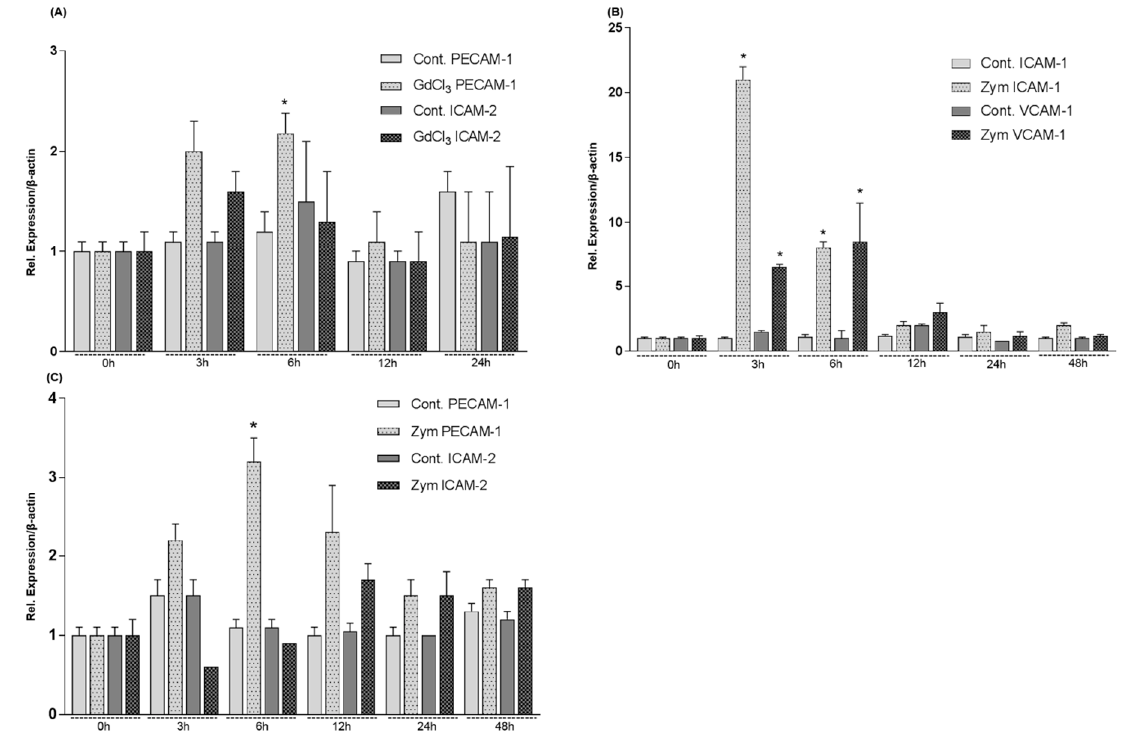
Figure 7. Fold change of mRNA expression of adhesion molecules in intraperitoneally administrated GdCl 3 and Zymosan rat livers at different time points related to controls. ( A ) Maximum increase of PECAM-1 gene expression is detected at 6 h by RT-PCR and of ICAM-2 at 3 h in GdCl 3 treated rat livers. ( B ) Maximum increase of ICAM-1 gene expression is detected at 3 h by RT-PCR whereas VCAM-1 gene expression showed a significant increase at 6 h. ( C ): Maximum increase of PECAM-1 gene expression is detected at 6 h by RT-PCR, whereas ICAM-2 gene expression increased at 12 h in Zymosan treated rat livers. The results were normalized to the housekeeping gene β -actin and experimental errors are shown as ± SEM values of six experiments (in duplicate) compared with controls for each time point (* p < 0.05, analyzed by one-way ANOVA).